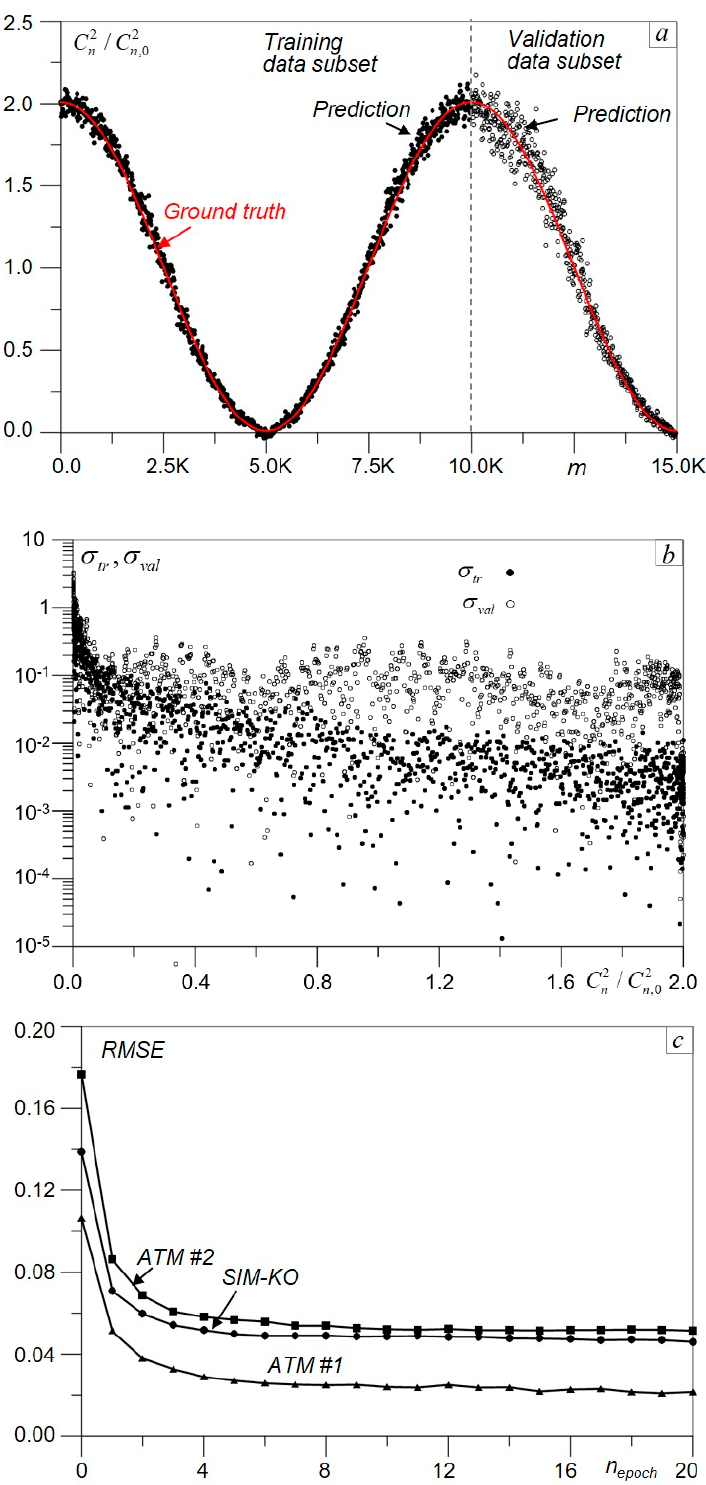
Figure 6. Selected results of the Cnˆ2Net model training and validation: ( a ) comparison of C 2 n true (solid curve) and predicted values (dots) computed for training (solid dots) and validation (circles) data subsets of the SIM-KO dataset; ( b ) prediction error standard deviations σ tr and σ val for DNN training and validation performed on the SIM-KO data subsets; ( c ) DNN learning curves for three di ff erent datasets. The results are averaged over N model = 20 Cnˆ2Net models in ( a , c ) and N model = 50 in ( b ). Index m corresponds to the image frame stamp in each dataset.